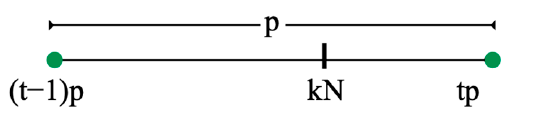
Figure 20. Determining the interval of succeeding multiples of p enclosing a multiple of N. Furthermore, two different multiples of N are in different intervals defined by succeed- ing multiples of p. Otherwise, the situation of Figure 21 would imply that N ≤ p , which is a contradiction as shown by the proof of Note 9 below.